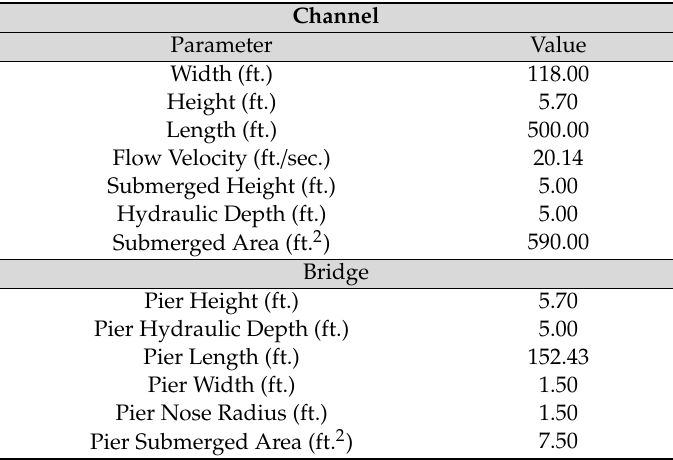
Table 2. Duck Creek Channel and bridge dimensions.